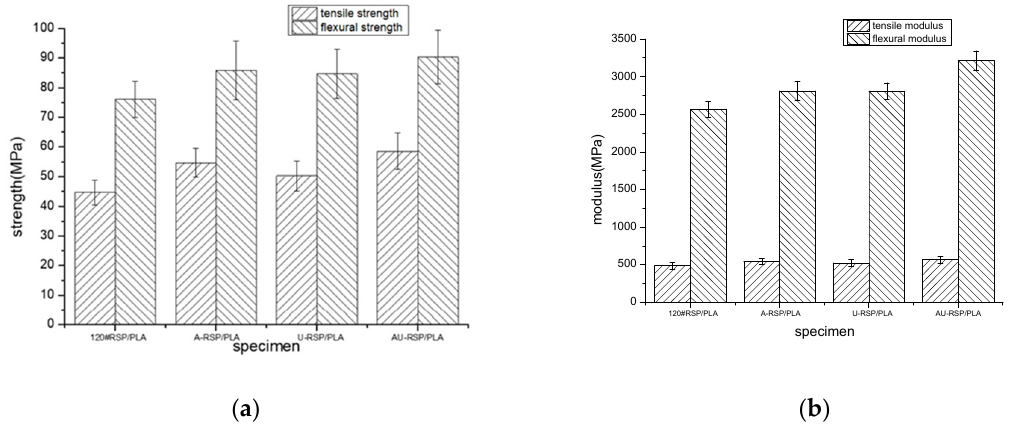
Figure 5. Mechanical properties of 3D-printed materials: ( a ) strength and ( b ) modulus.